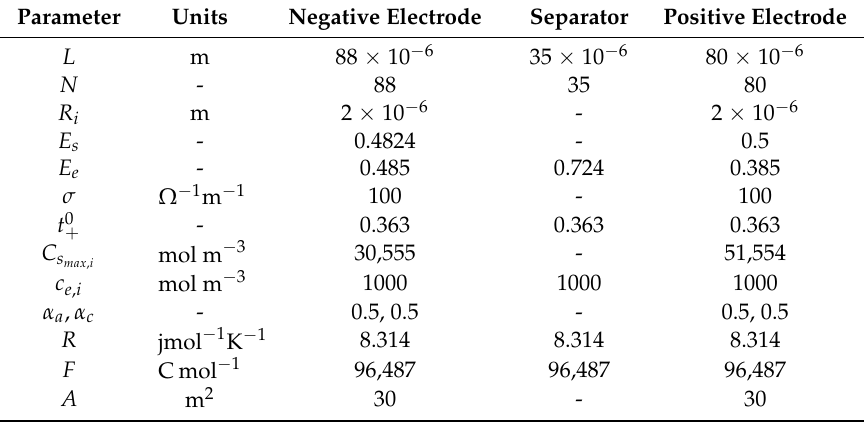
Table 1. Battery parameters [16].